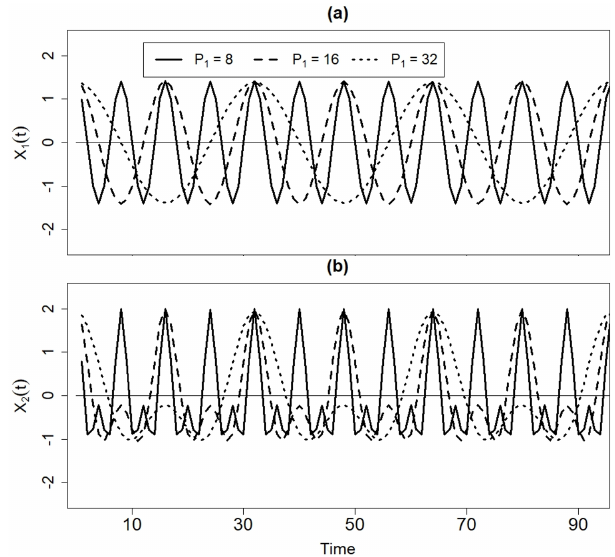
Figure 1. (a) The time series X 1 (t) and (b) X 2 (t) for different val- ues of P 1